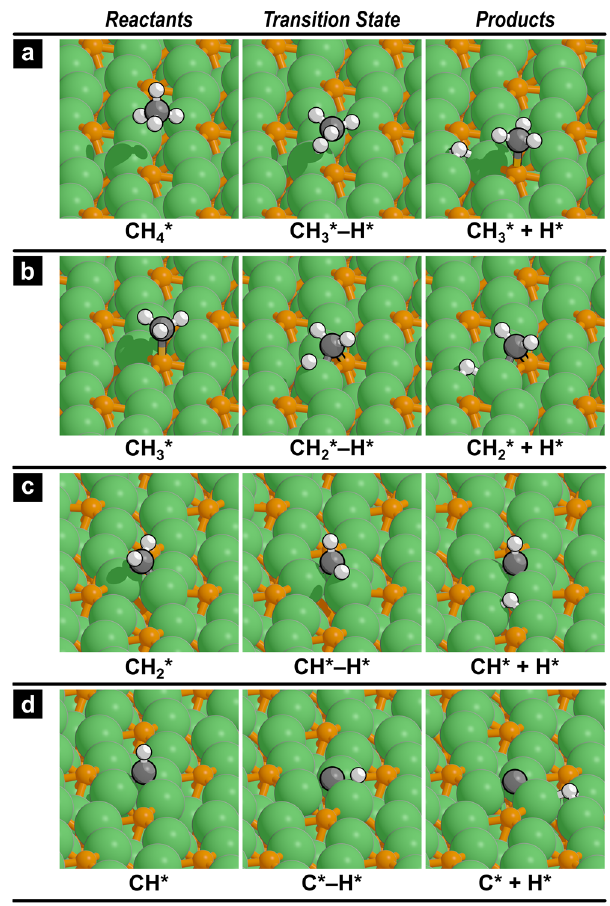
Figure 2. Reactants, transition state, and product structures for the dehydrogenation reaction of ( a ) CH 4 , ( b ) CH 3 , ( c ) CH 2 , and ( d ) CH on Ni 2 P(001) surface.